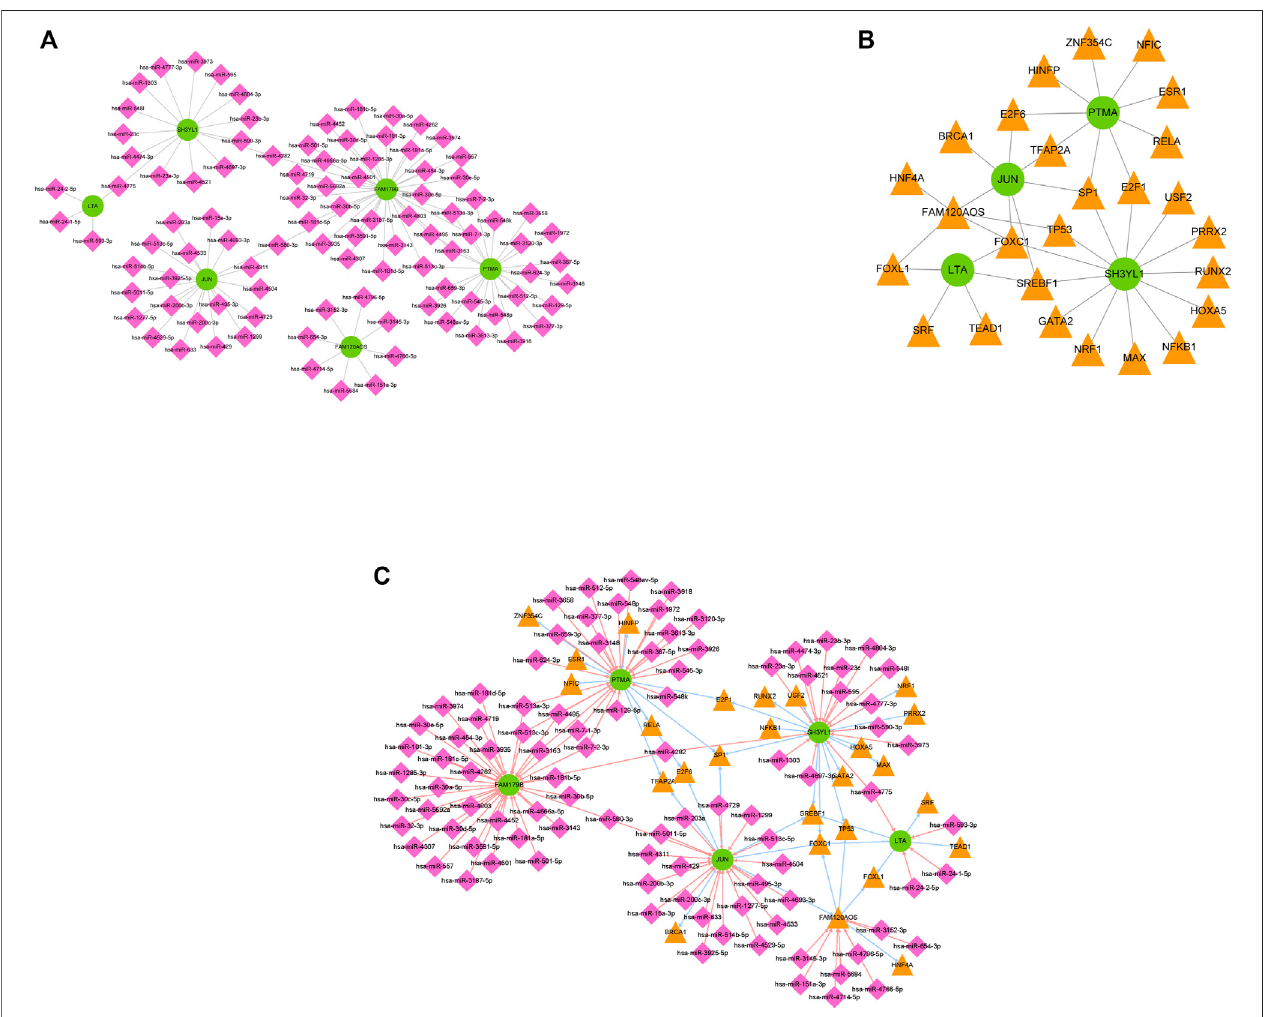
FIGURE 6 | The regulating mechanisms of diagnostic markers. (A) The miRNA mRNA regulatory network comprising 97 miRNAs, 6 diagnostic markers, and 106 edges. (B) The mRNA-TF regulatory network comprising 38 mRNA TF pairs. (C) The miRNA-mRNA-TF network of 6 diagnostic markers.